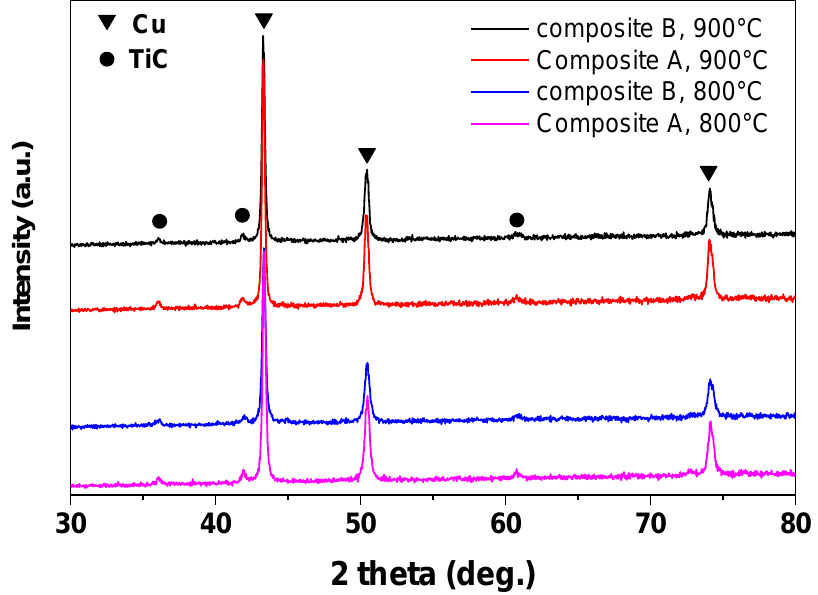
Figure 3. XRD patterns of nanocomposite A and nanocomposite B containing 20 vol % TiC sintered at 800 and 900 °C.